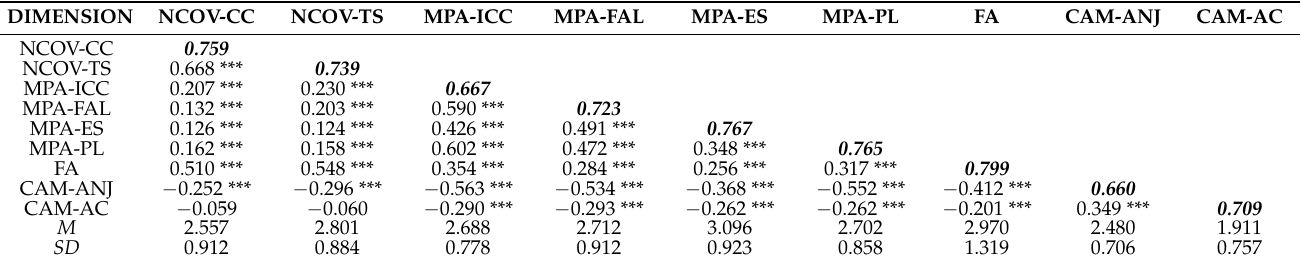
Table 5. Discriminant validity.